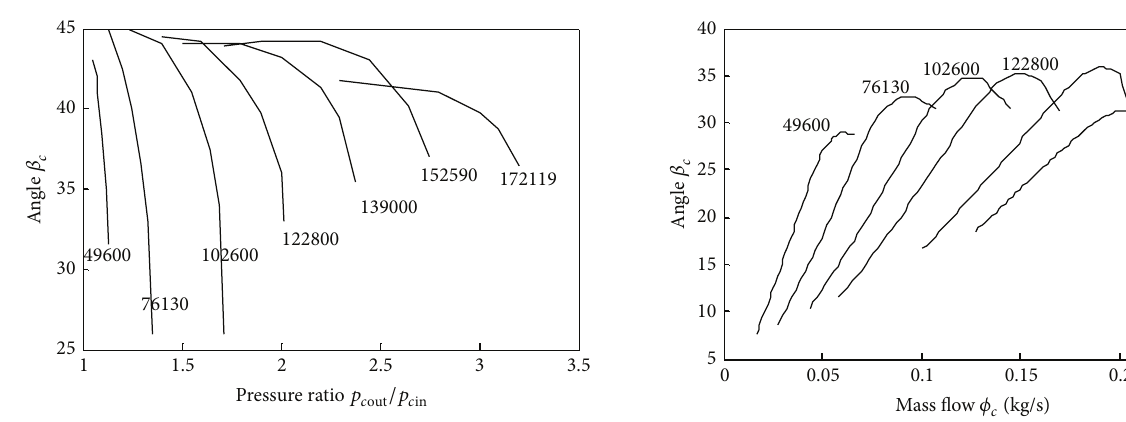
Figure 4: Optimal angle as parameter of compressor mass flow model (the unit of compressor speed is rpm).